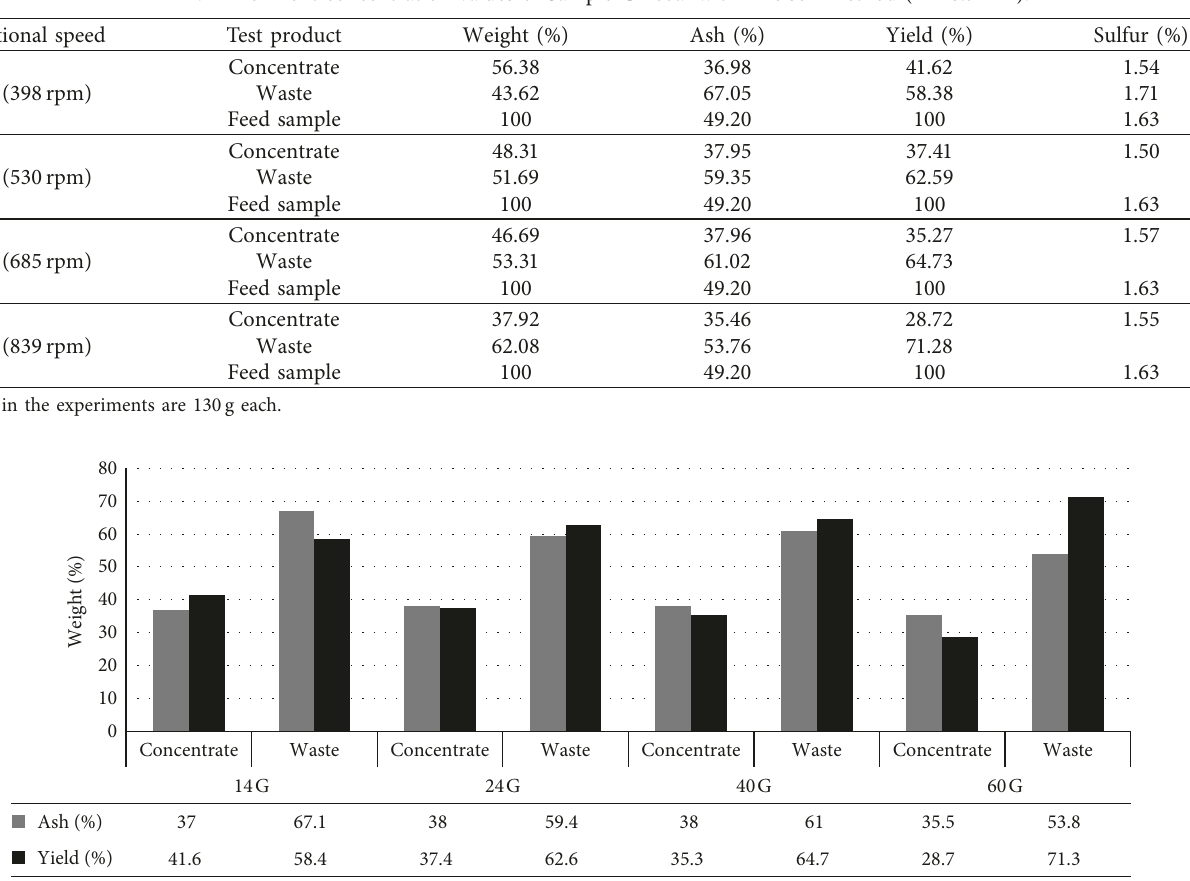
Table 11: Enrichment concentration values of Sample-C2 coal with Knelson method (